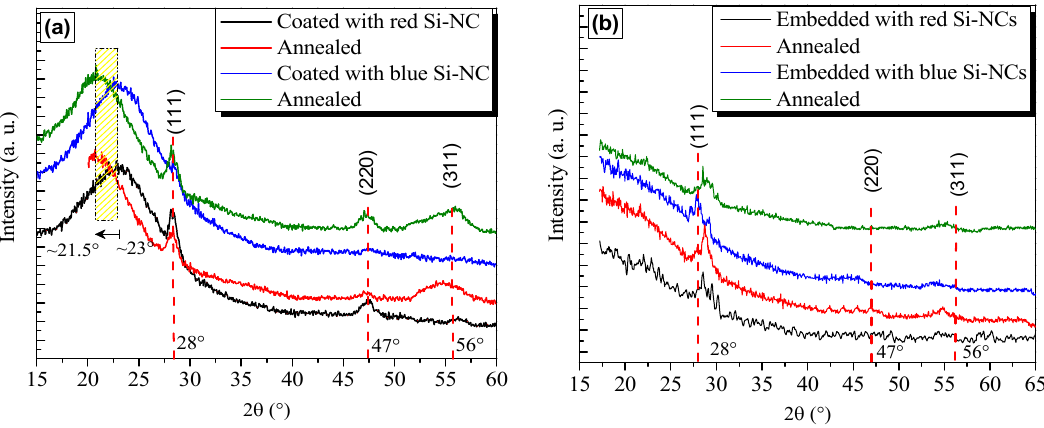
Figure 4. Grazing incidence XRD (X ‐ ray diffraction) (0.5°) patterns from coated ( a ) and embedded films; ( b ) with red and blue light ‐ emitting Si ‐ NCs, before and after annealing at 1100 °C for 3 h in N 2 atmosphere.